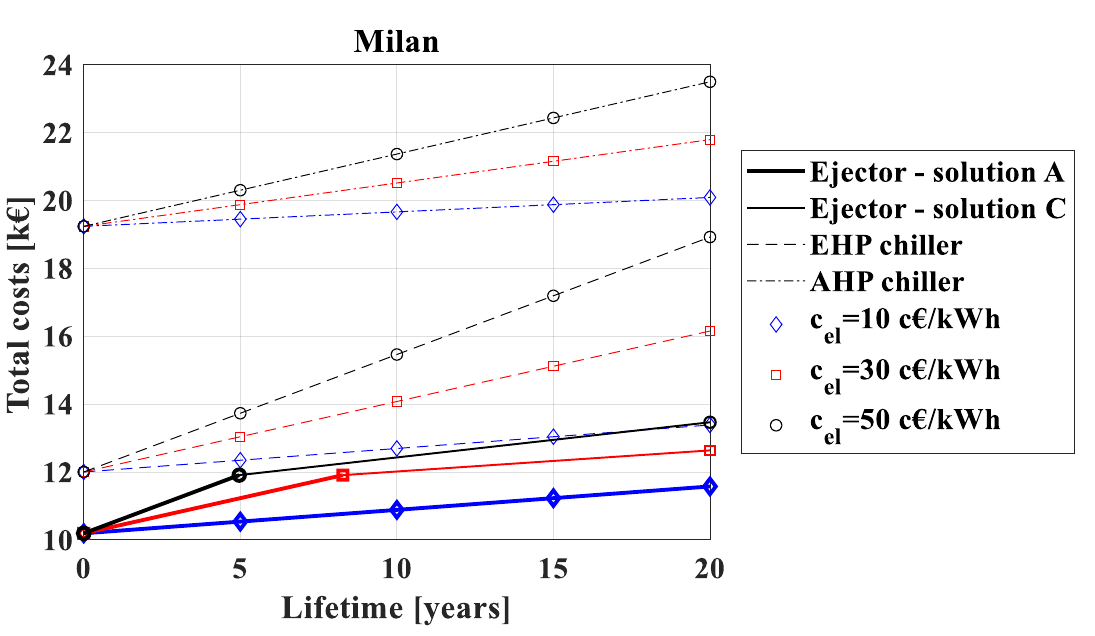
Figure 9. Total costs as function of economic lifetime and electric energy unit price for Milan climatic zone, and comparison between hybrid ejector cycle and current technology.